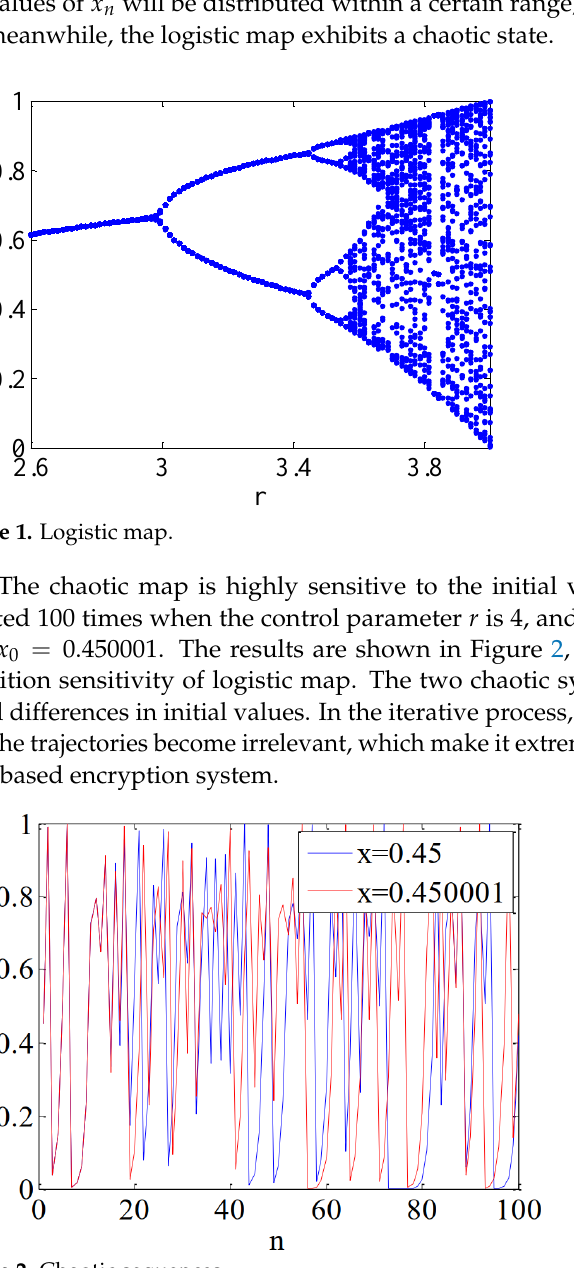
Figure 2. Chaotic